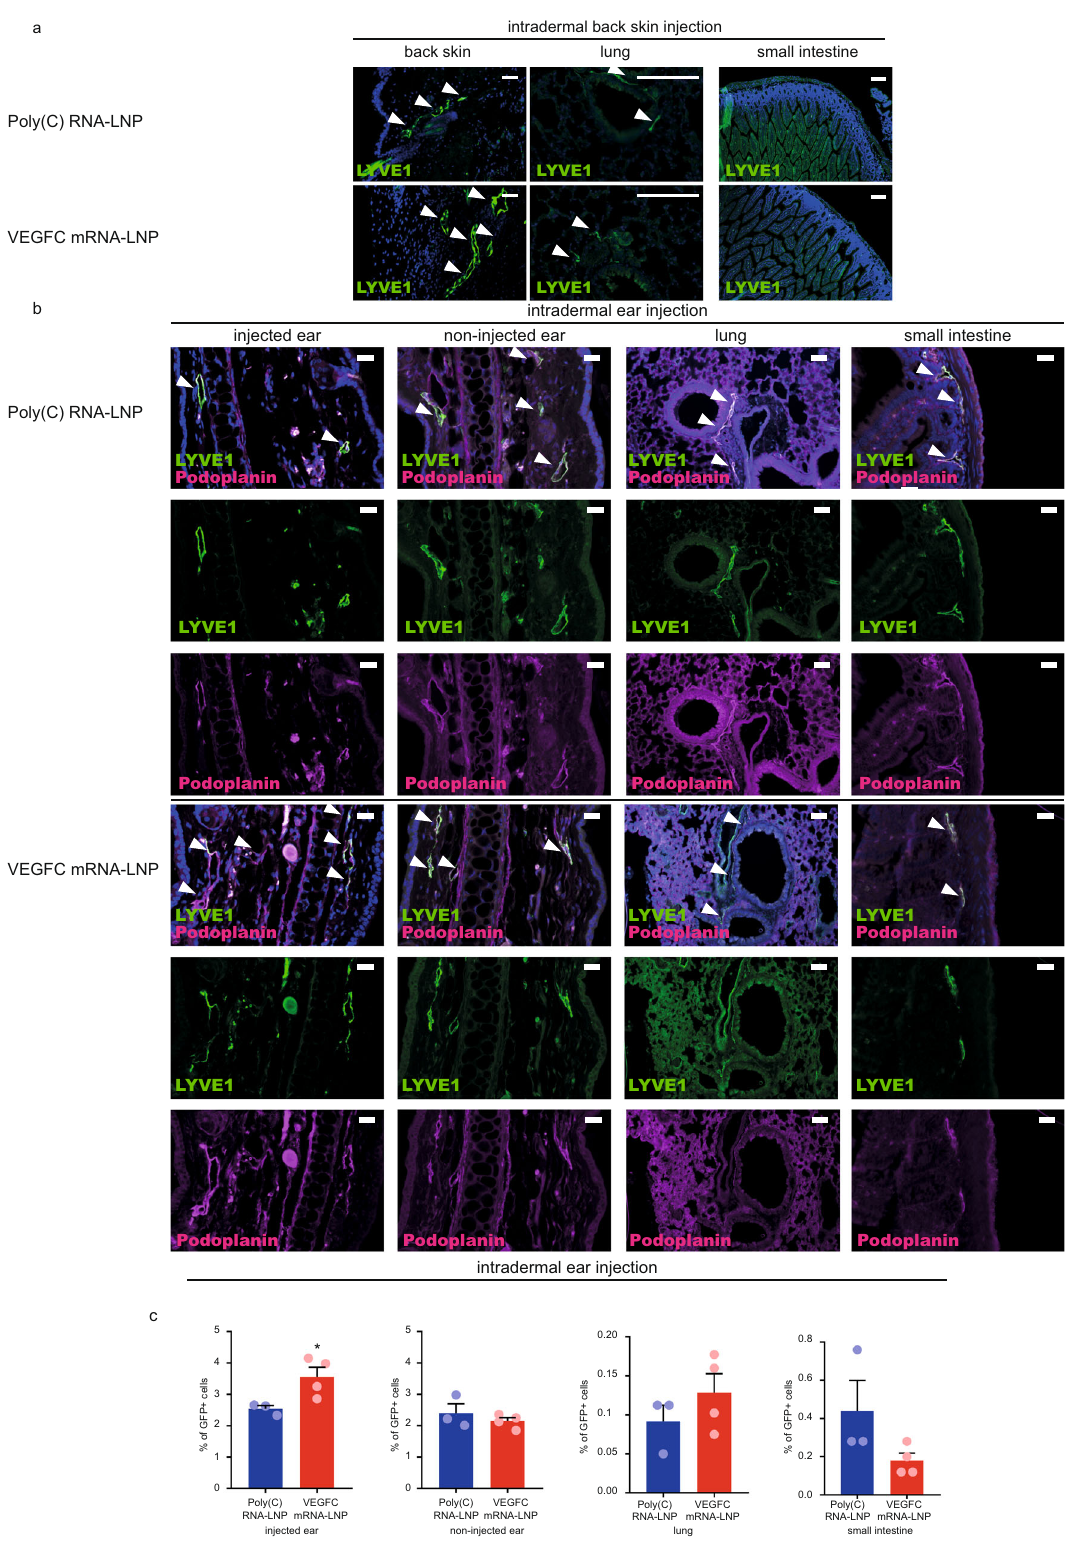
blood vessel formation and immune cell in fi ltration compared to Poly(C) RNA-LNP delivery (Fig. 5, Supplementary Fig. 7). Our fi ndings are in accordance with previous studies which demon- strated that VEGFC, in contrast to VEGFD which induces both blood and lymph vessel growth in adults, did not have a major